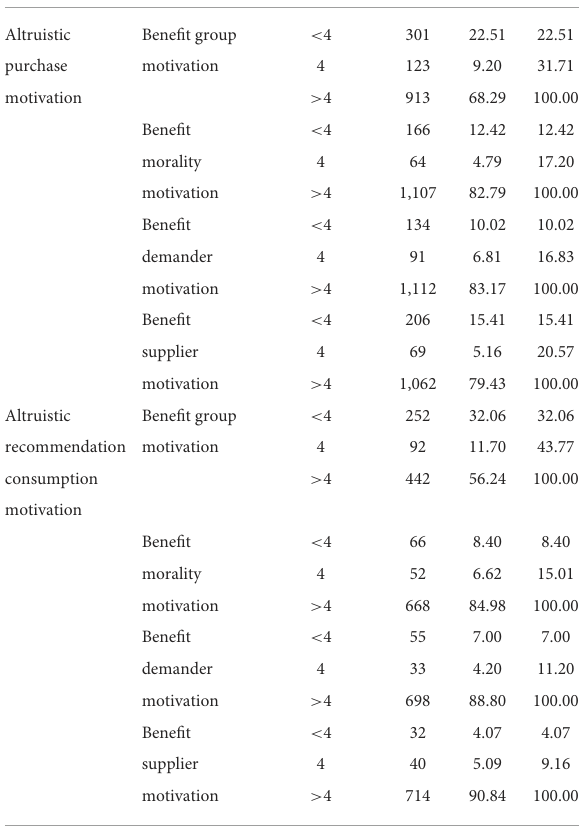
TABLE 3 Distribution of variable